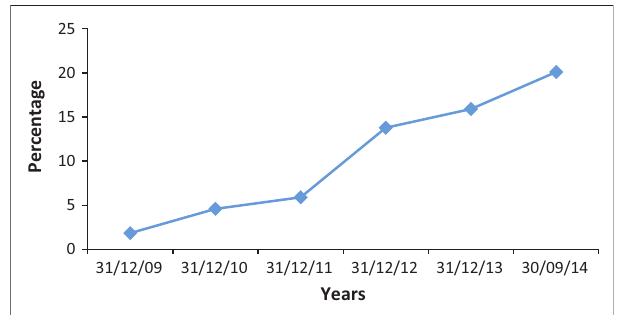
FIGURE 1: Non-performing loans.